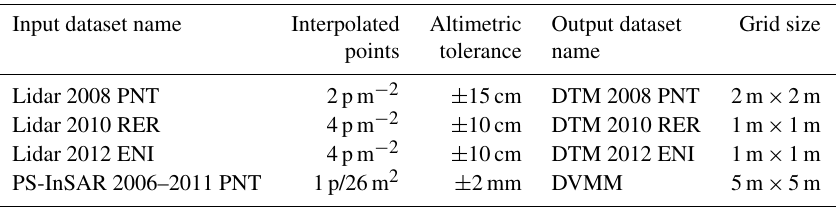
Table 3. Description of the four input models employed for the definition of case studies CS1 and CS2. PNT stands for Piano Nazionale di Telerilevamento (National remote sensing